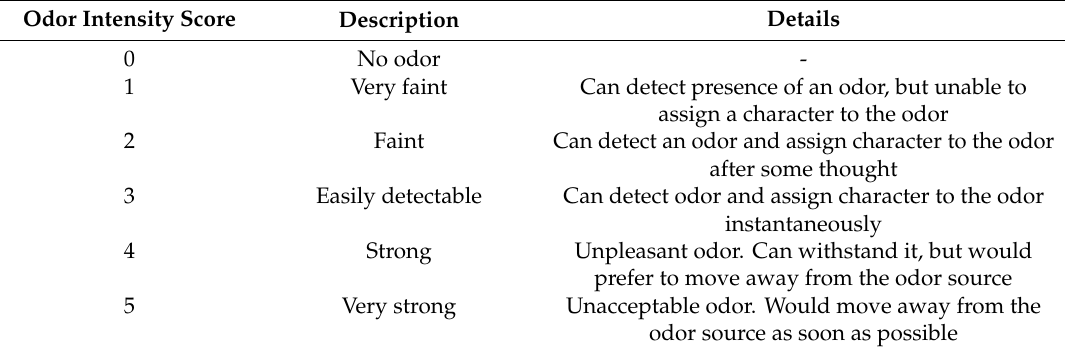
Table 4. Odor intensity scale, modified from Turk et al. (1980)